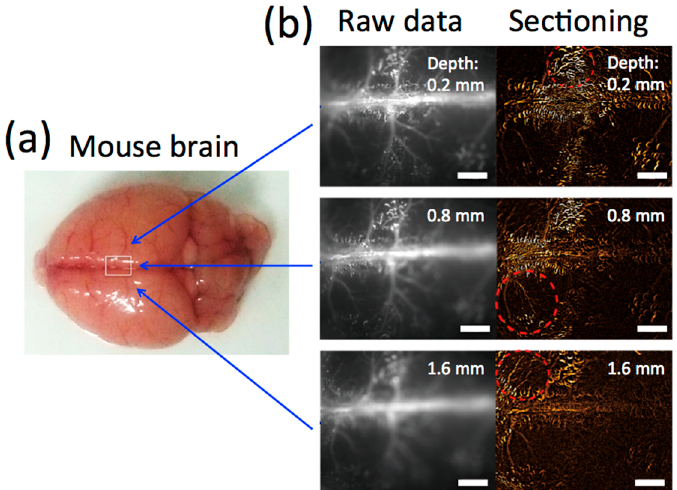
Figure 5. ( a ) Bright field image of a mouse brain isolated; ( b ) Raw fluorescence images and sectioning images at depths of 0.2 mm, 0.8 mm, and 1.6 mm from the surface. The sectioning image was obtained from a raw image minus its previous and next image. Red circles with dotted lines show cerebral blood vessels appearance after sectioning. Scale bars: 1